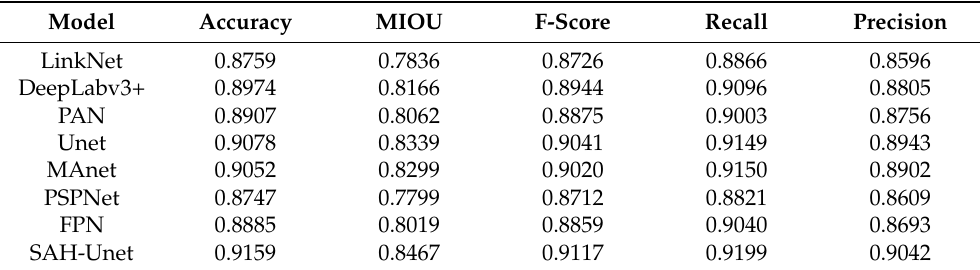
Table 4. Comparison table of model metric